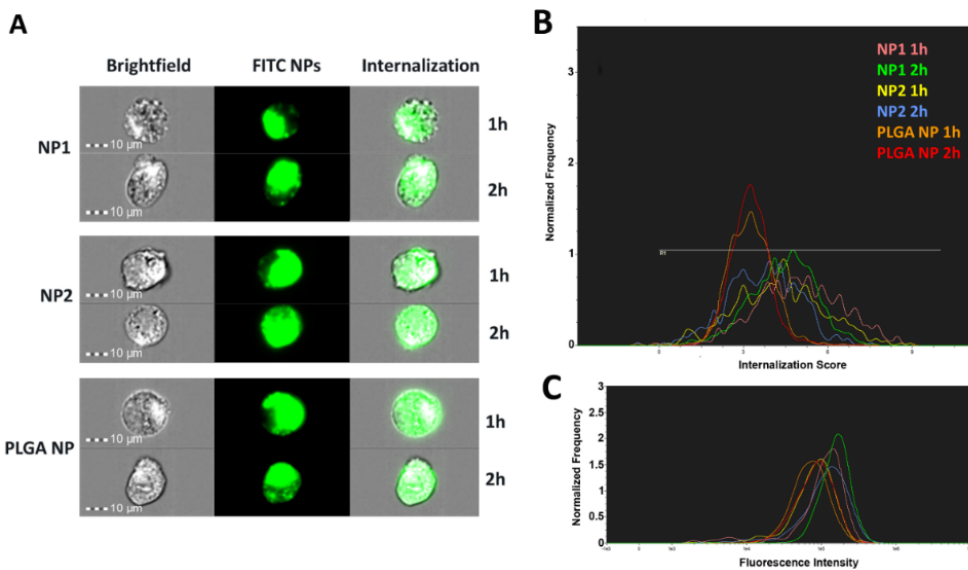
Figure 7. Fluorescence images for FITC-labeled NP internalization by HUVEC ( A ) after 1 h or 2 h treatment, obtained by ImageStream ® X. ( B , C ) The histograms of NP internalization and fluorescence intensity. The respective statistical analysis is reported in Table 2a,b.